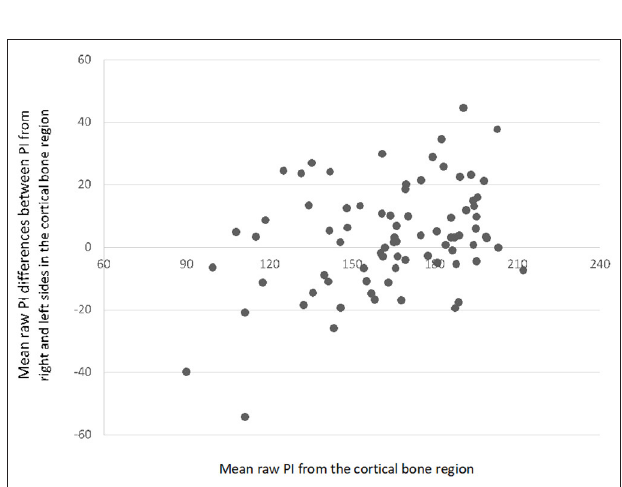
FIGURE 4 | Scatterplot with mean differences between pixel intensity (PI) values from the right and left sides in the cortical bone region ( N = 80).